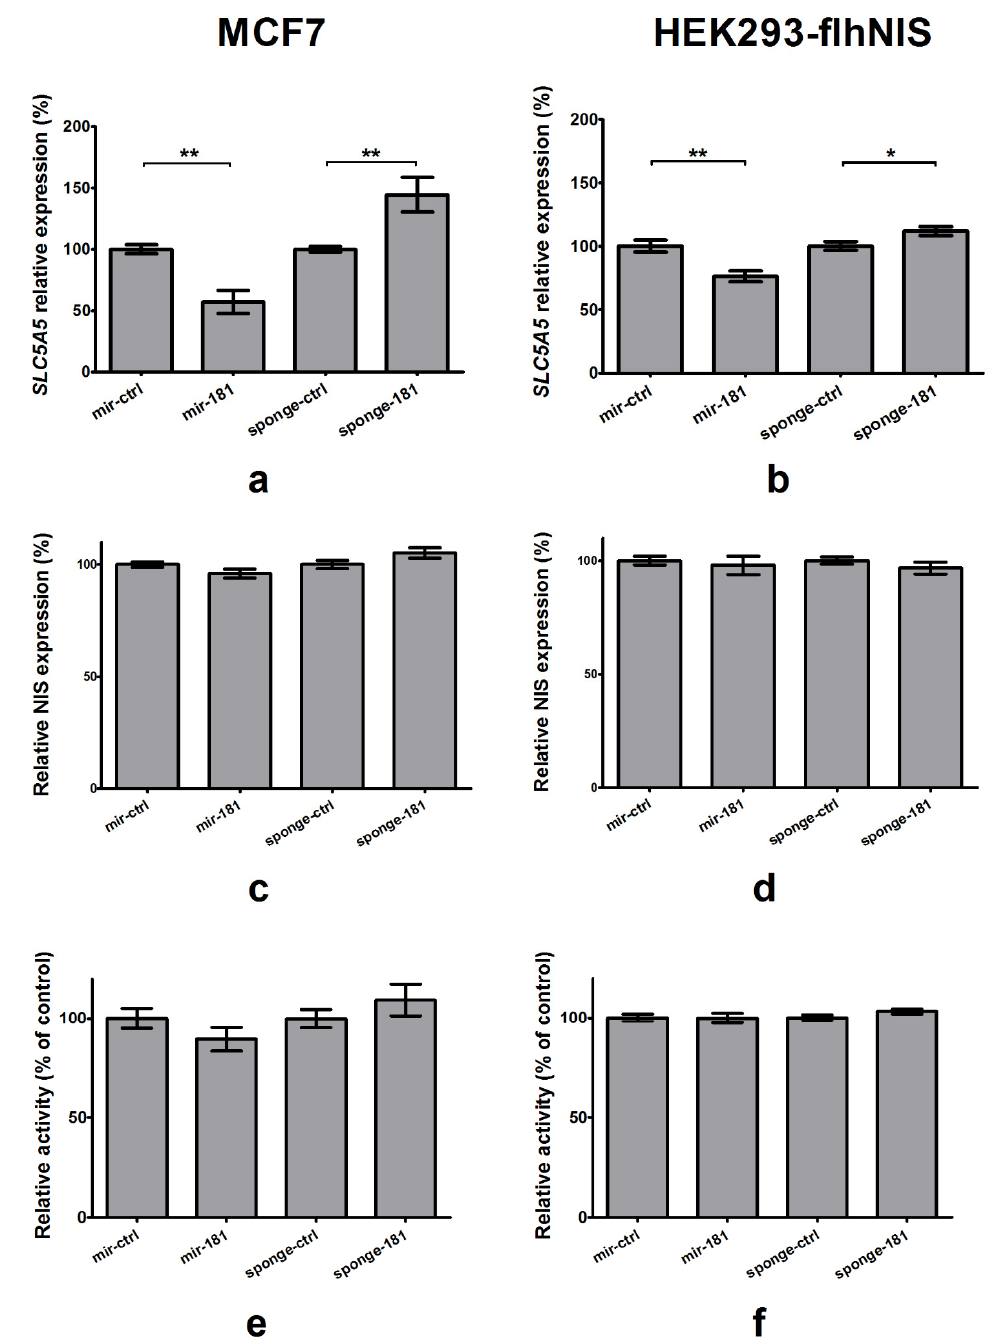
Figure 6. Impact of miR-181a-5p on NIS expression and function. ( a ) Transfection of MCF7 cells with mir-181-expressing plasmid reduced SLC5A5 mRNA by 43% ( p = 0.001), whereas silencing of miR-181a-5p using sponge decreased SLC5A5 by 45% ( p = 0.0045). ( b ) In HEK293-flhNIS, overexpression of mir-181 led to a reduction in SLC5A5 mRNA expression by 24% ( p = 0.0045), while miR-181a-5p silencing increased SLC5A5 expression by 12% ( p = 0.036). NIS expression measured using ELISA in ( c ) MCF7 cells induced with all-trans retinoic acid and dexamethasone, and ( d ) HEK293-flhNIS cells. Tendencies for lower expression upon transfection with mir-181-expressing plasmid are visible for both cell lines. Tendency for higher expression can be seen upon transfection with a plasmid silencing miR-181a-5p in MCF7 cell line. Radioiodine uptake in ( e ) MCF7 cells induced with all-trans retinoic acid and dexamethasone, and ( f ) HEK293-flhNIS cells. Tendencies for lower retention upon transfection with mir-181-expressing plasmid and for higher expression upon transfection with a plasmid silencing miR-181a-5p are visible for both cell lines. Data are expressed as mean values +/ − SEM. Statistical analysis was performed using a Mann–Whitney test ( a , b ) and an unpaired t -test ( c – f ); * p < 0.05, ** p <